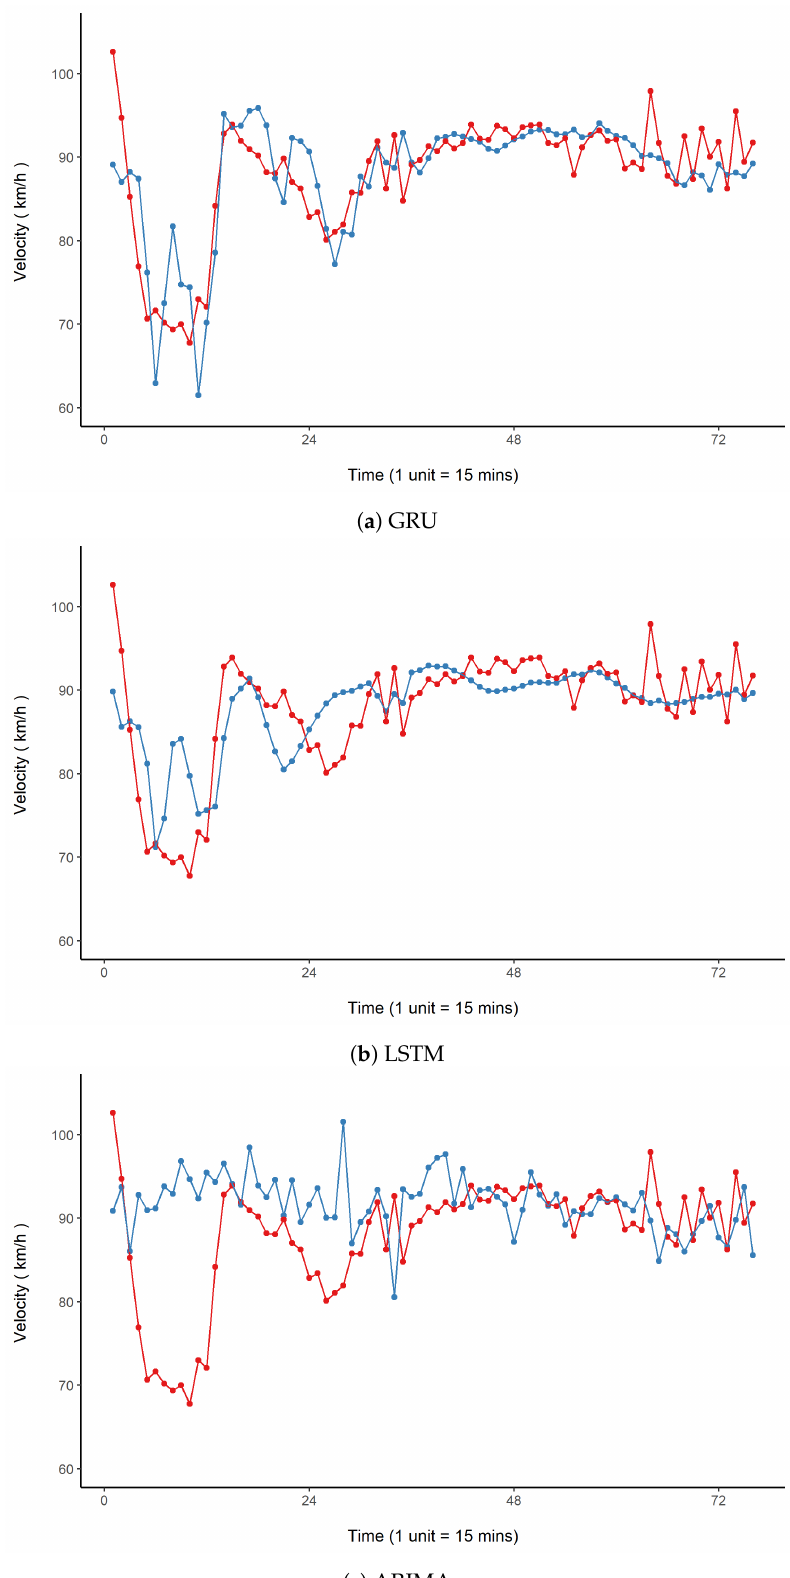
Figure 9. Performance comparisons in bus lanes: red color for ground truth and blue color for